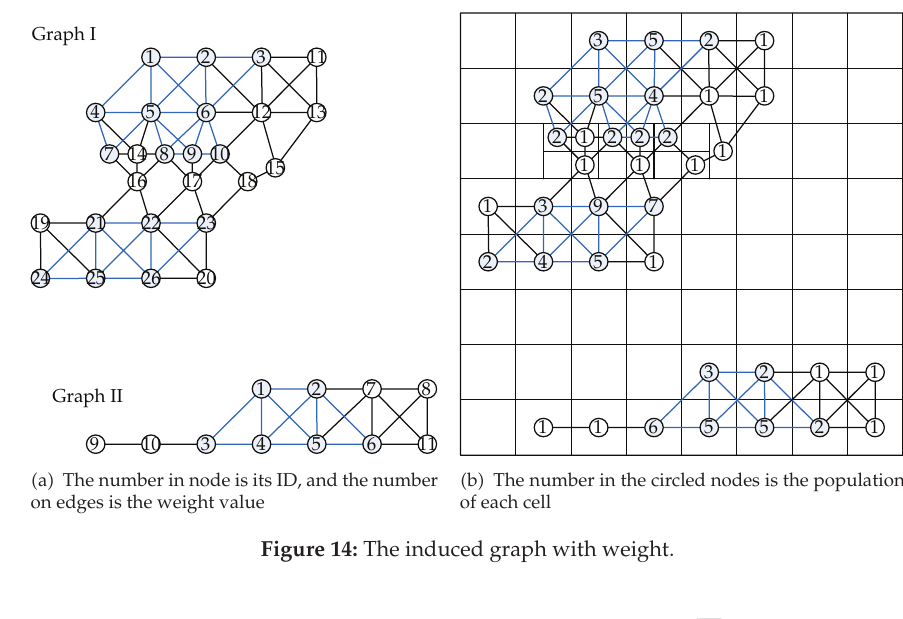
Figure 14: The induced graph with weight.